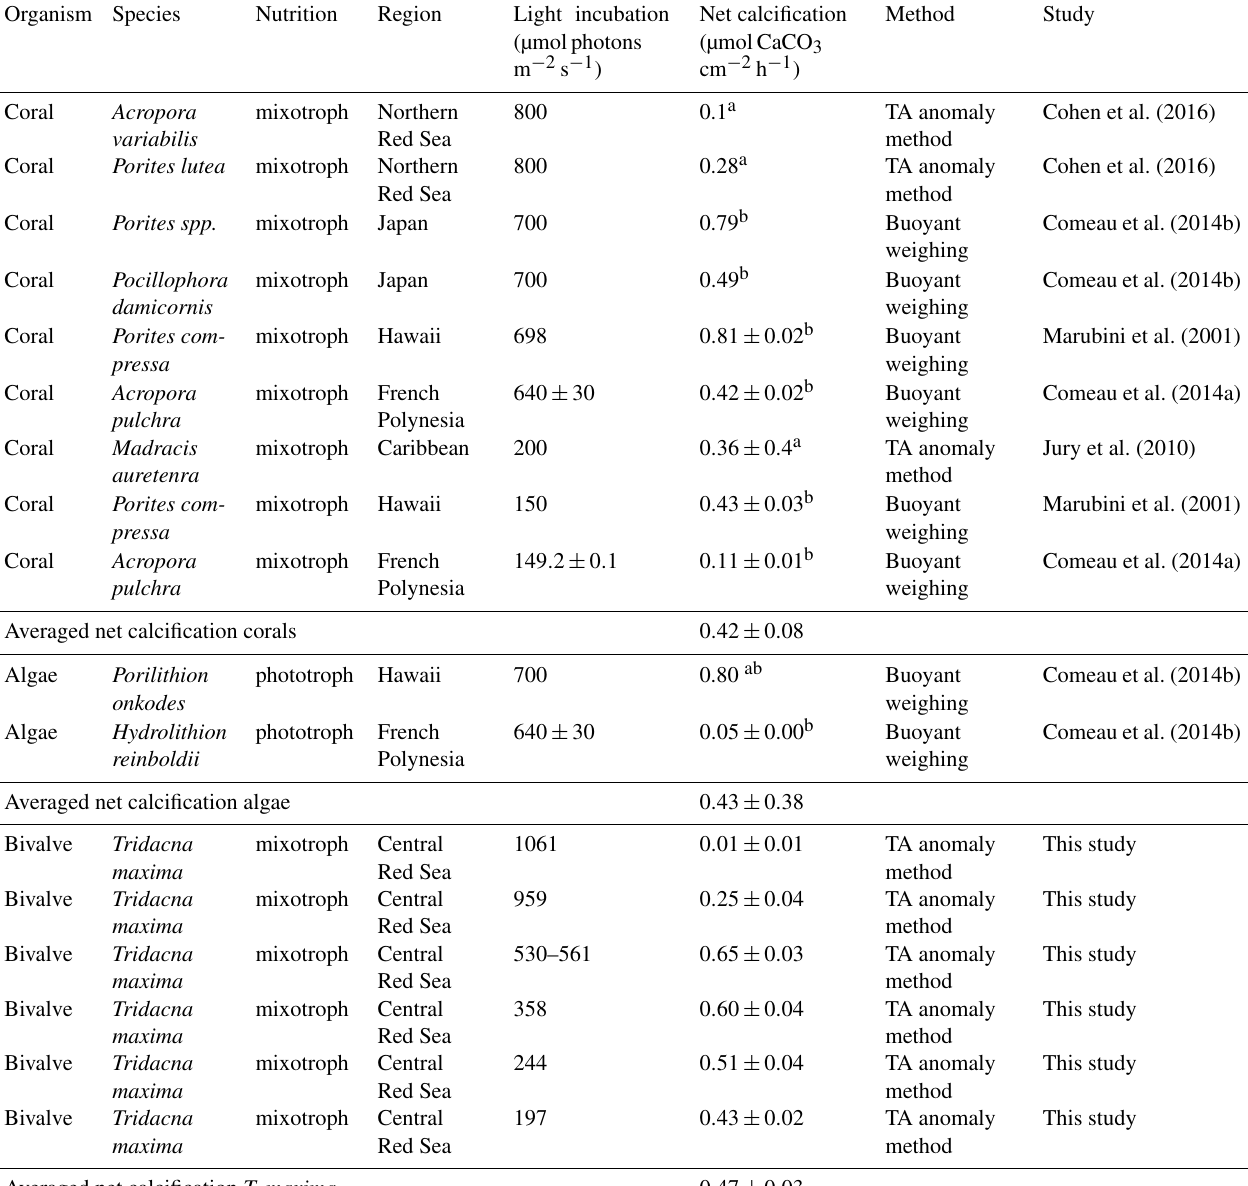
Table 3. Comparison of net calcification rates in relation to light conditions in different marine phototrophic and mixotrophic calcifiers. Values are given as average value mean ( ± SE) or a ( ± SD). Experimental light incubation levels are given in µmolphotonsm − 2 s − 1 .